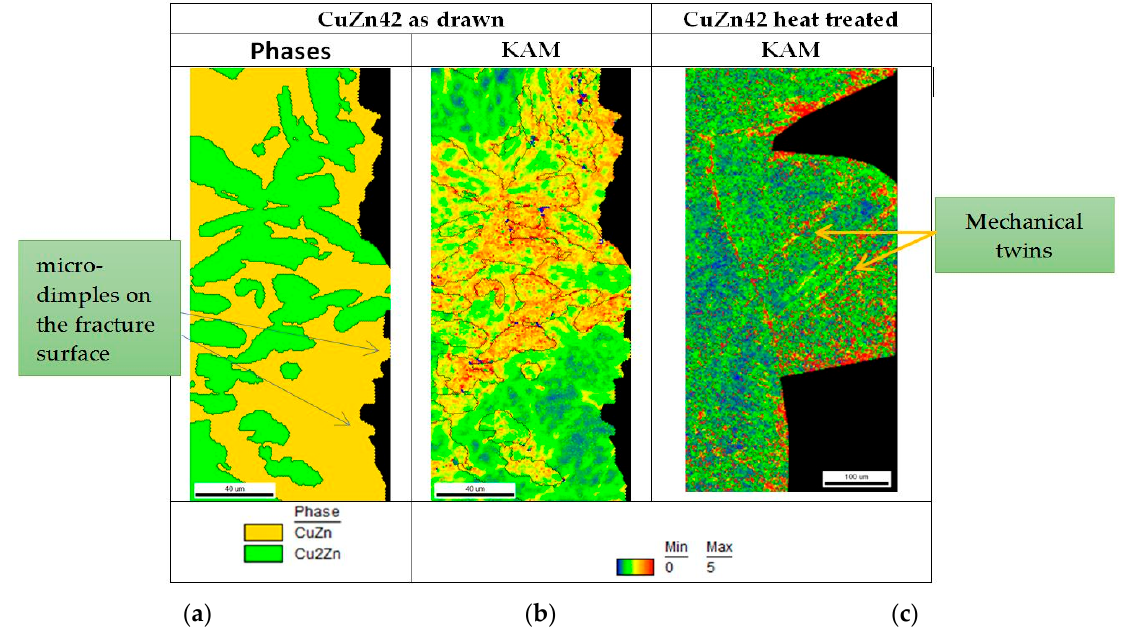
Figure 7. Phase and KAM maps of the fracture surface profile of Charpy impact tested CuZn42 alloy samples: ( a ) phase map, ( b ) KAM map in the as-drawn condition, and ( c ) KAM map in the heat treated condition. Unit: µ